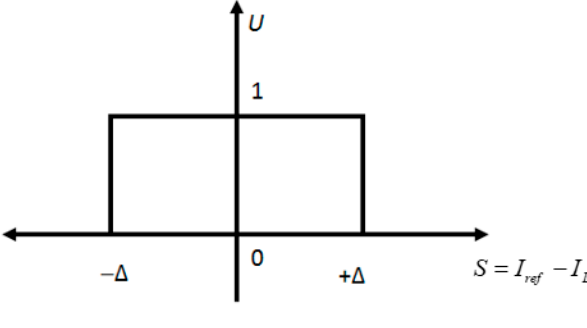
Figure 3. Single-phase hysteresis.